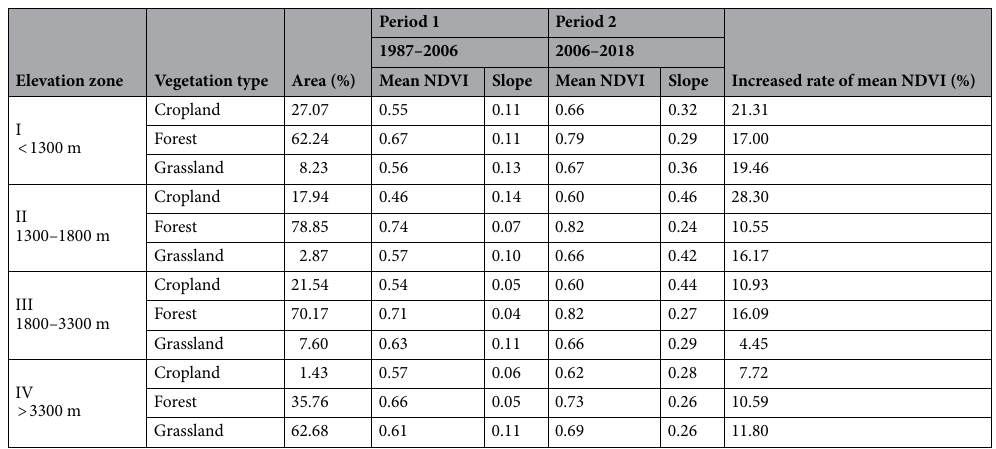
Table 2. Area percentage of each classification and mean NDVI as well as its slope for different vegetation types under four Elevation Zone during 1987–2006 and 2006–2018 in Qin Mountains. Area (%) refer to the area percentage of different elevation zone type.